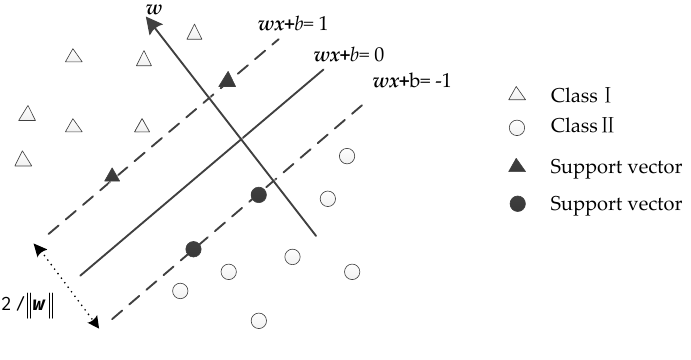
Figure 11. Classification principle of SVM.